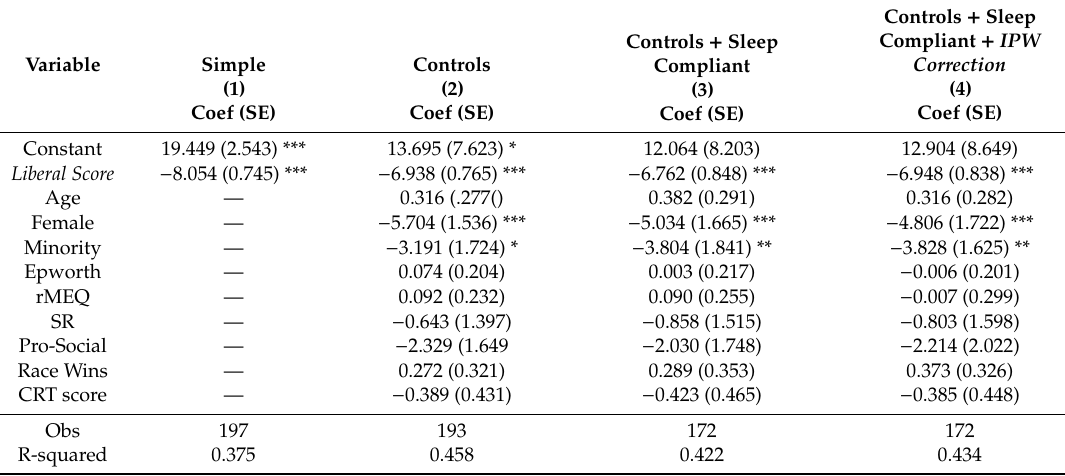
Table A2. Impact of Liberal Score on Pro-Gun-Rights